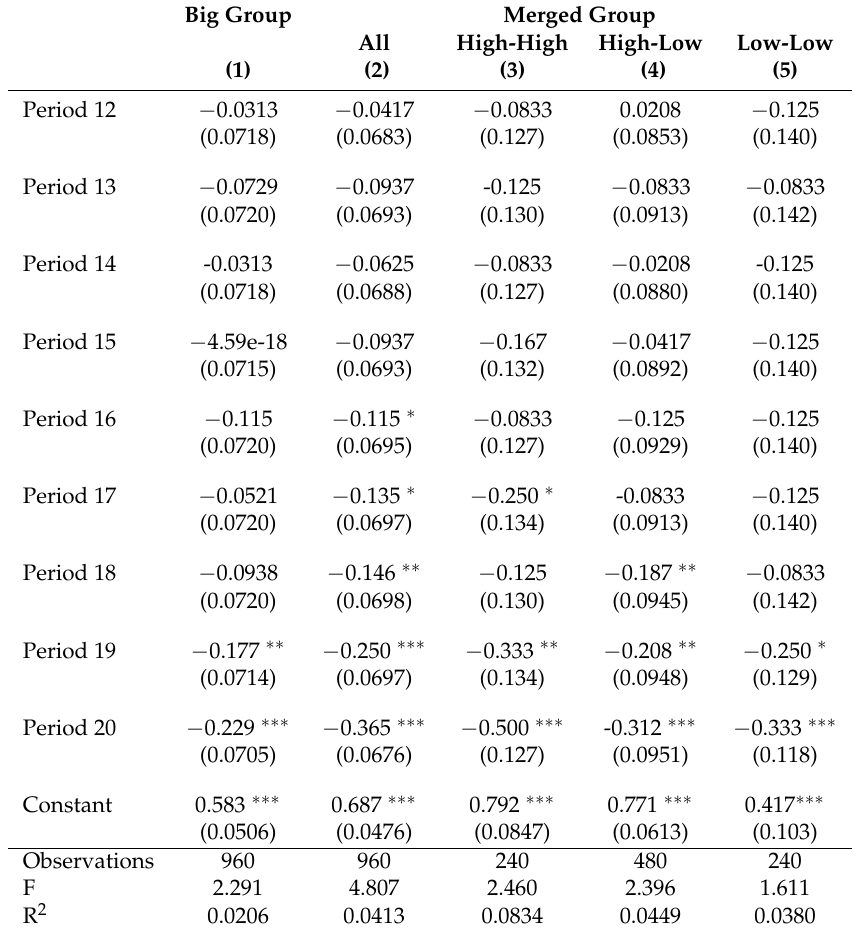
Table A17. Part B: time trends by treatment and